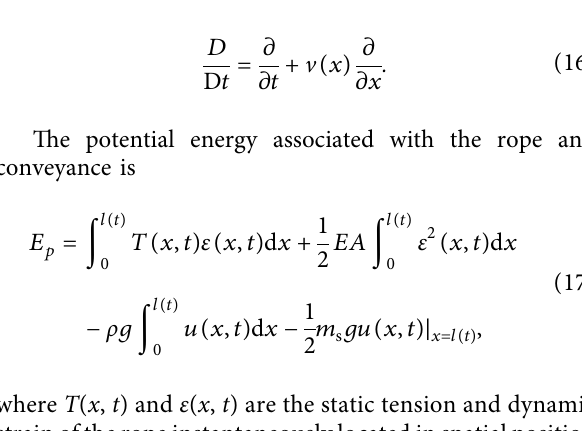
Figure 5: Hoisting velocity derived from rope winding. (a) Hoisting acceleration during the whole winding process. (b) Enlarged view of region D. (c) Enlarged view of region E. (d) Enlarged view of region F.